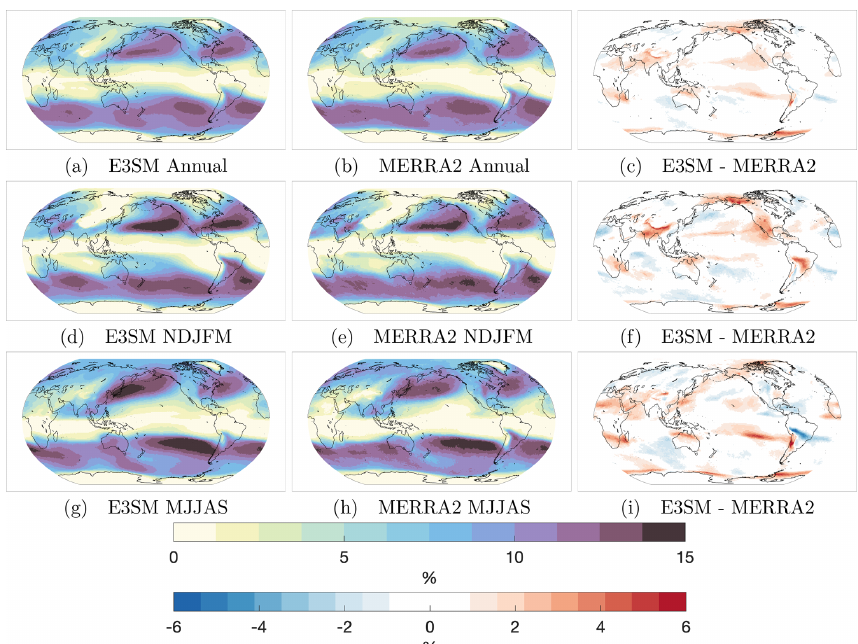
Figure 1. The AR frequency at each grid point globally for the annual (a–c) , extended winter NDJFM (d–f) , and extended summer MJJAS (g– i) periods. The E3SM frequencies (a, d, g) , MERRA2 frequencies (b, e, h) , and the difference in frequencies between E3SM and MERRA2 (c, f, i) . The color bar at the top (bottom) corresponds to the absolute (difference in) frequencies.